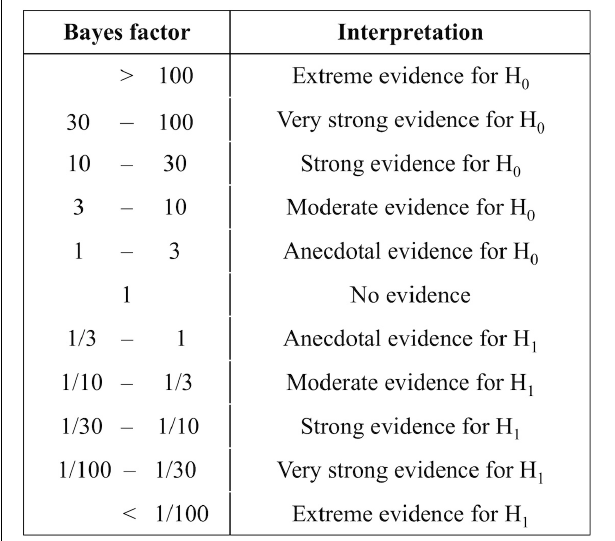
FIGURE 2 | Evidence categories for the Bayes factor (Jeffreys,